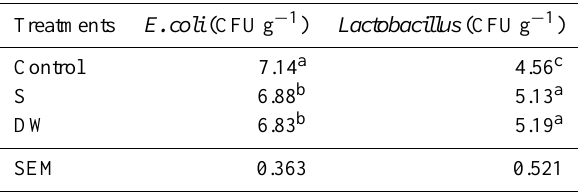
Table 5. The effect of sumac and whey powder diets on intestinal microbial population of female broiler